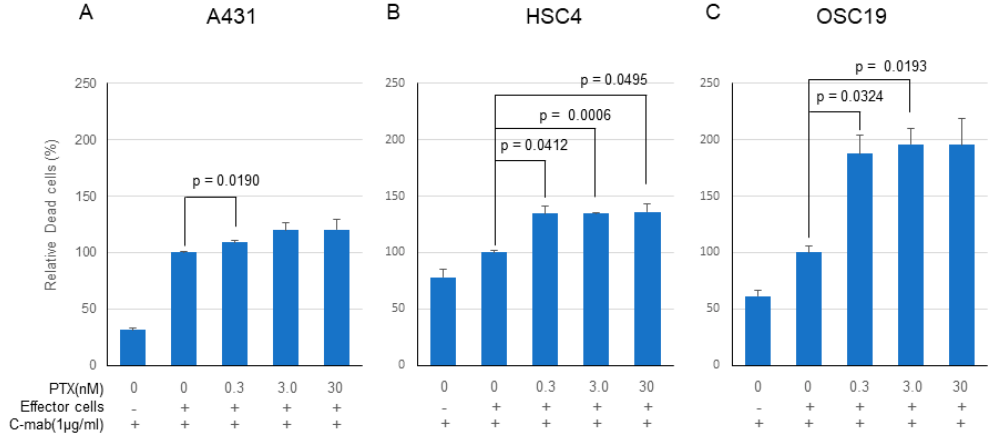
Figure 4. Cell-killing activity of PTX and C-mab combination treatment with ADCC induction.